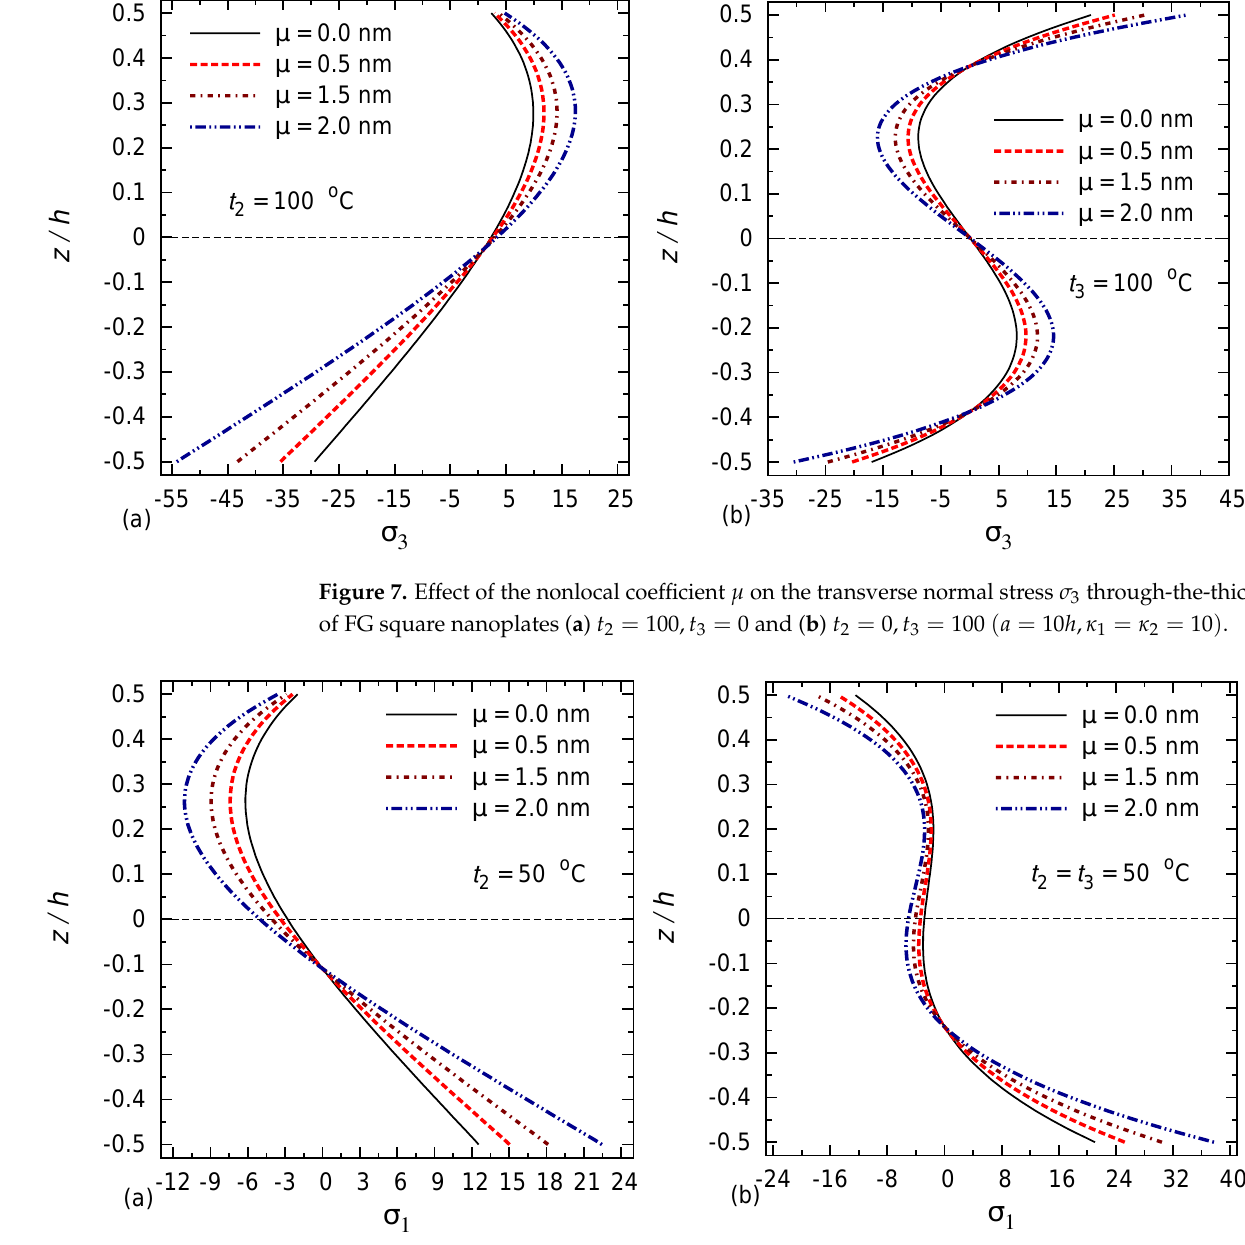
Figure 8. Effect of the nonlocal coefficient µ on the in-plane normal stress σ 1 through-the-thickness of FG square nanoplates ( a ) t 2 = 50, t 3 = 0 and ( b ) t 2 = t 3 = 50 ( a = 10 h , κ 1 = κ 2 = 10 )